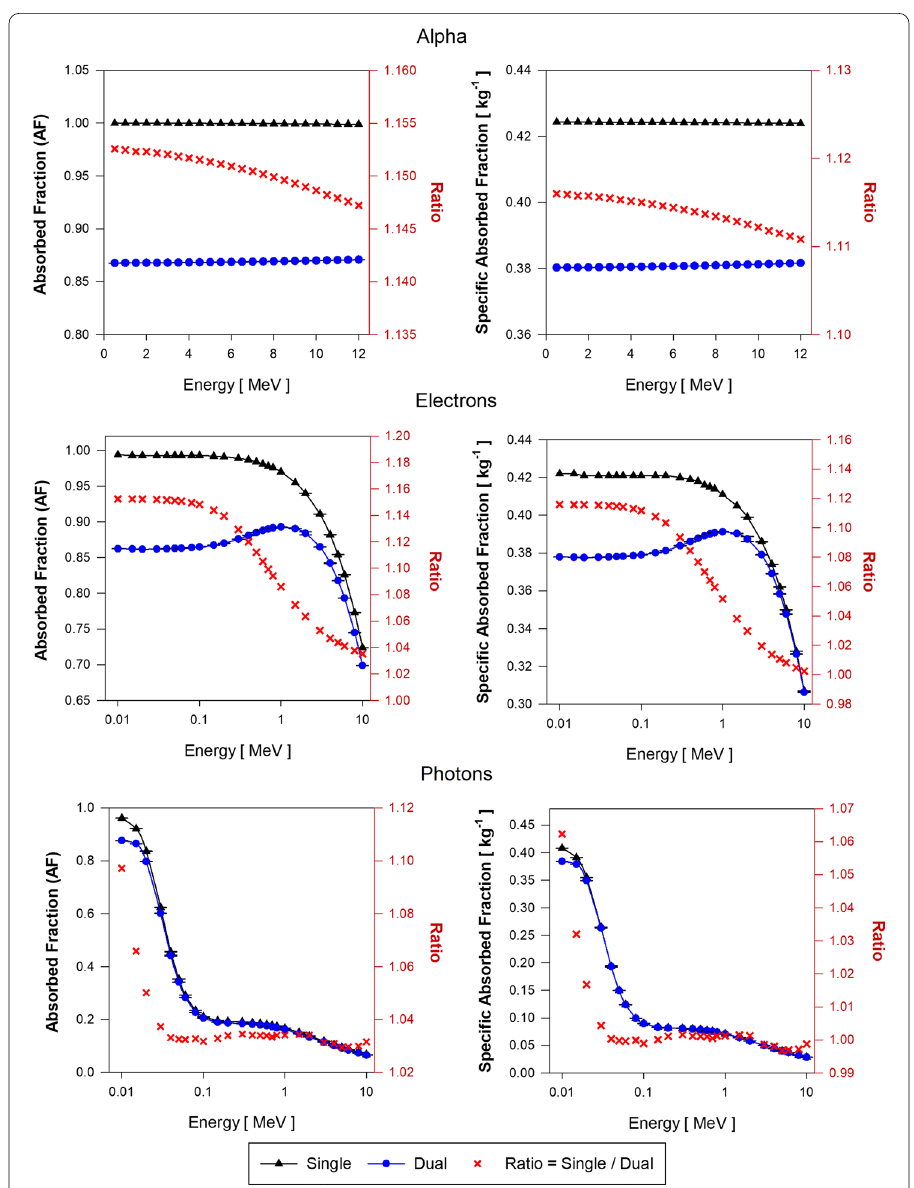
Fig. 9 Approximations of AF ( LP ← LB ) and SAF ( LP ← LB ) for monoenergetic alpha particles (Top), electrons (Center), and photons (Bottom) using the single‑region liver model (black triangles) and the dual‑region liver model (blue circles) in tetrahedral mesh‑type format for the reference adult male liver